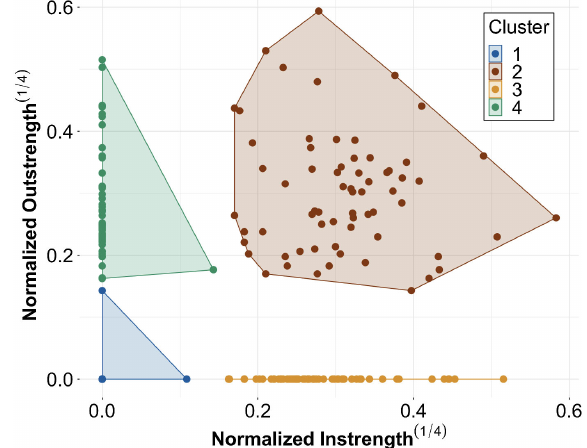
FIG. 8. Histogram of the normalized outstrength data using the fourth root transformation. Though we maintain a peak at zero, the rest of the data exhibit a fairly normal distribution.